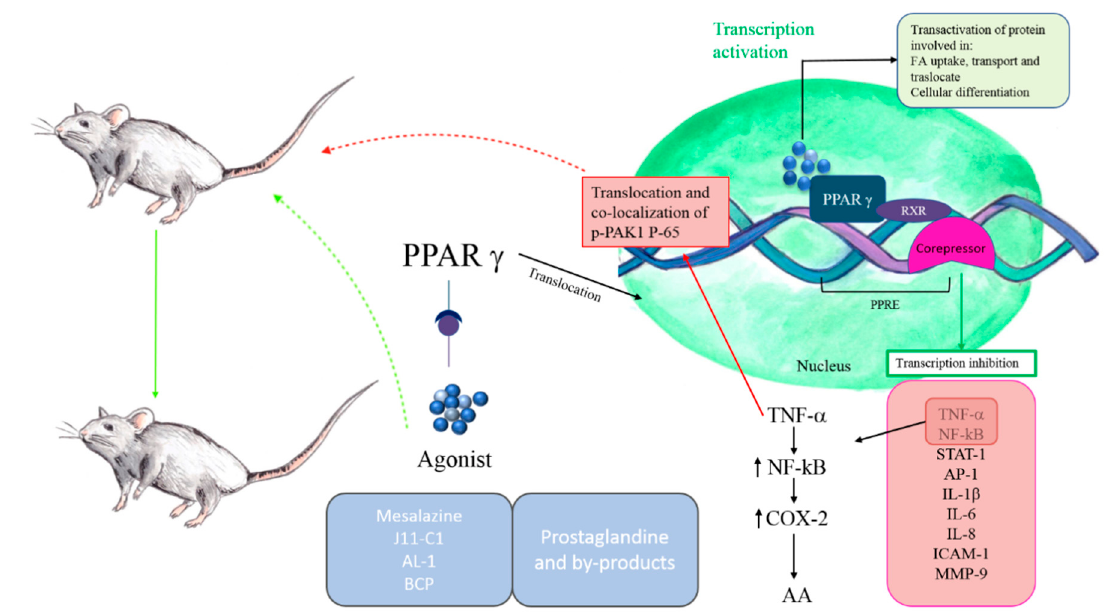
Figure 1. Peroxisome proliferator-activated receptors- γ (PPAR γ ) in IBDs. PPAR γ belongs to the family of nuclear receptors. Its activation involves the translocation in nucleus and the heterodimerization with retinoid X receptor (RXR). The heterodimers bind to sequence-specific PPAR response elements (PPREs), stimulating the transcription of target genes. Corepressors maintain the target genes inactivated in absence of PPAR γ ligands. The protective effects of PPAR γ include the modulation of pro-inflammatory cytokines production, such as TNF γ , IL-6, the inhibition of transcription factors, including NF-kB, STAT-1, AP-1, and intercellular adhesion molecule and MMP-9. PPAR γ also determines the downregulation of p65 expression and IkappaB kinase. In contrast, TNF- α activates NF-kB, which stimulates COX-2 to convert arachidonic acid in prostaglandins. The anti-inflammatory properties of prostaglandins are related to their ability to bind PPAR γ , blocking NF-kB downstream events. PPAR γ synthetic agonists can ameliorate IBD inflammation.